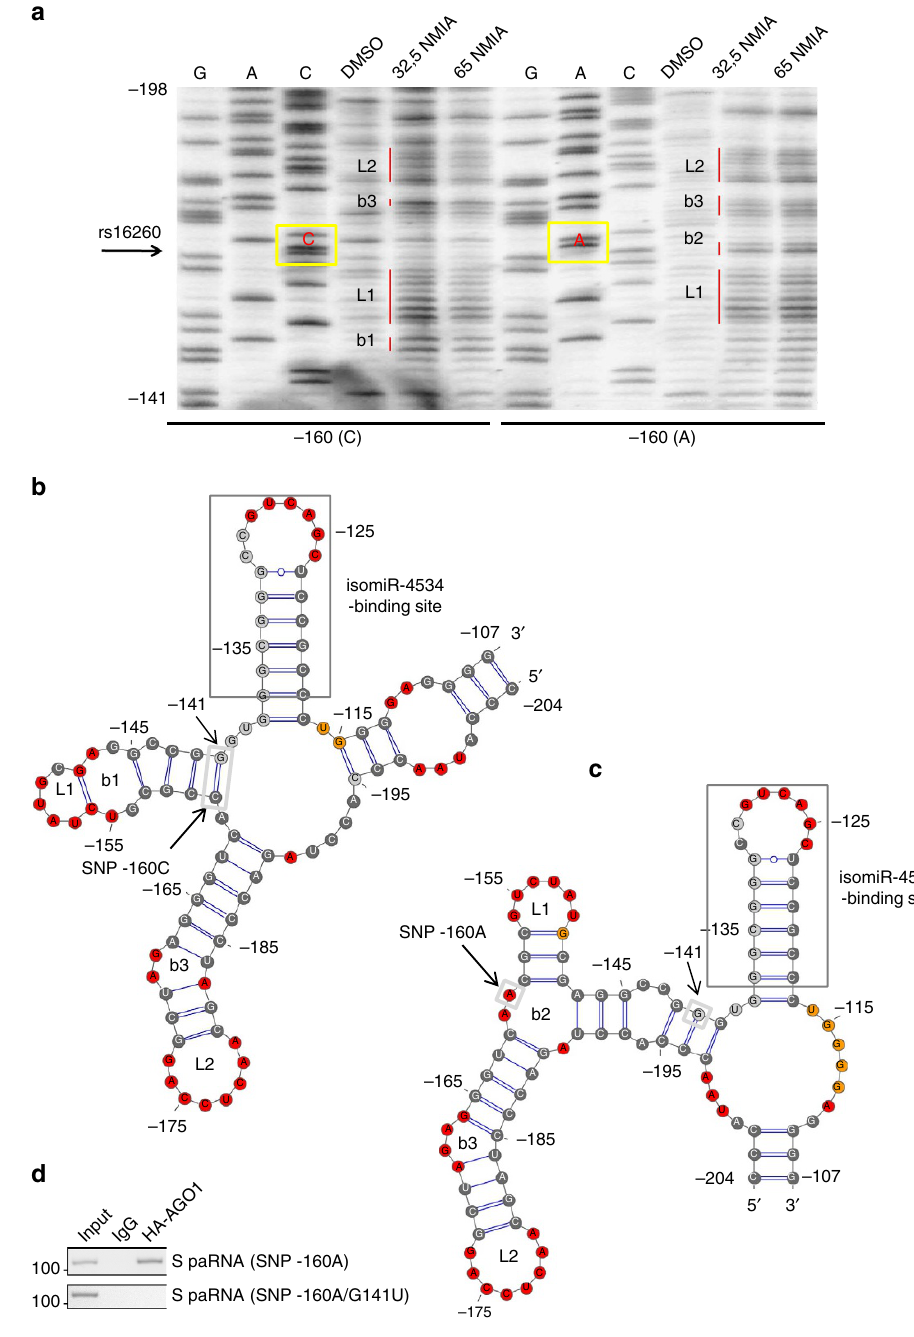
Figure 7 | SNP rs16260 influences folding of sense promoter-associated RNA. ( a ) SHAPE reactivity gel analysis of the sense transcript ( (cid:2) 688/ (cid:2) 57) showing the region encompassing SNP rs16260 with C (left) and A (right) variants. G, A, and C, sequencing lanes. Samples were incubated with 0 (DMSO), 32 or 65mM NMIA. Yellow boxes, position of the polymorphic site with either C or A variant. ( b , c ) Secondary structures of S-paRNA with the (cid:2) 160C ( b ) and (cid:2) 160A ( c ) allele built using RNAstructure based on SHAPE-derived constraints and visualized using VARNA. Colours mark nucleotides that are either unstructured (red, SHAPE Z 0.85), well-ordered (black, SHAPE o 0.4), with intermediate reactivity (orange) or non-resolved/undetectable (gray). ( d ) Binding of HA-AGO1 to (cid:2) 160A and mutated (cid:2) 160A/G141U S-paRNA determined by RIP. B, bulges; dark gray box, isomiR-4534 binding site; L, loops; light gray boxes, base pair in (cid:2) 160C allele disrupted in (cid:2) 160A